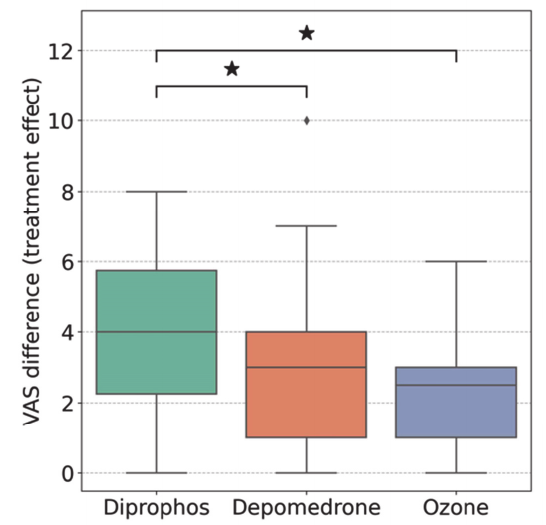
Fig. 2. Boxplots visualizing between-group difference in treat- ment effect. The asterisks denote a statistically significant dif- ference between the Diprophos and Depomedrone patients ( P =0.019) and between the groups of Diprophos and ozone patients ( P